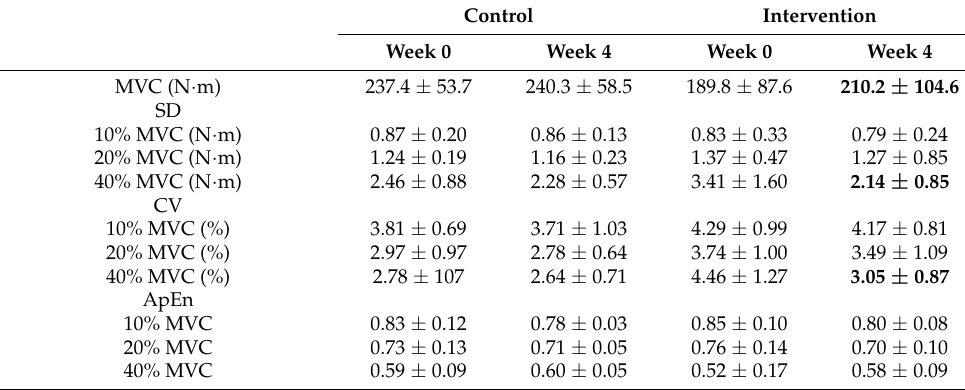
Figure 1. Individual changes (grey lines) in knee extensor MVC strength from baseline (week 0) to the end of the intervention (week 4). Left panel = control group; right panel = calisthenics intervention group. Dark lines represent group means. Table 2. Knee extensor strength, force control and Y balance test data from baseline (week 0) and the end of the intervention (week 4). Values are means ±